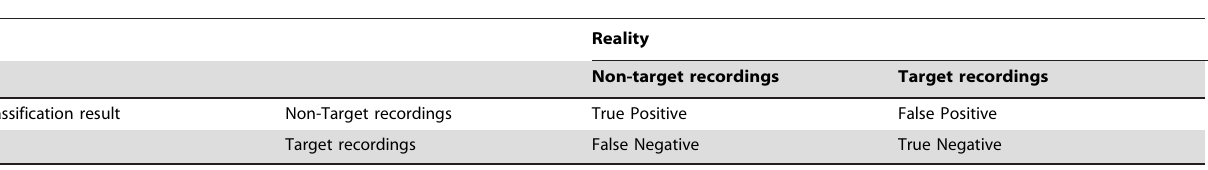
Table 1. Classification matrix of the